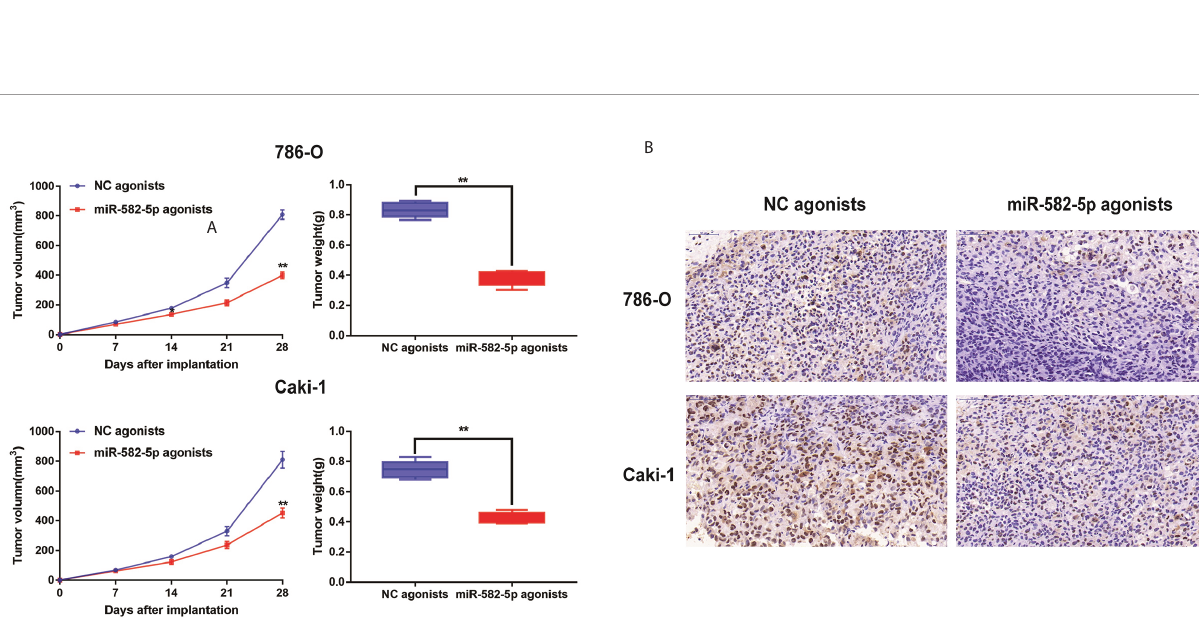
FIGURE 3 | MiR-582-5p promoted xenograft tumor formation. (A) Tumor volume and weight were calculated of the xenograft tumors in subcutaneous xenograft mouse model injected with 786-O and Caki-1 cells transfected with NC agonists and miR-582-5p agonists respectively. (B) The tumor sections from different transfected groups of xenograft mouse models were subjected to immunohistochemistry staining using antibodies against KLF6 (400×). The data are shown as the mean ± SD (** P < 0.01). The experiments were repeated three times with similar